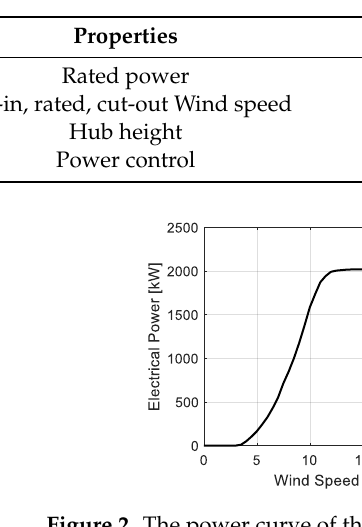
Table 1. General specification of the target wind turbine.